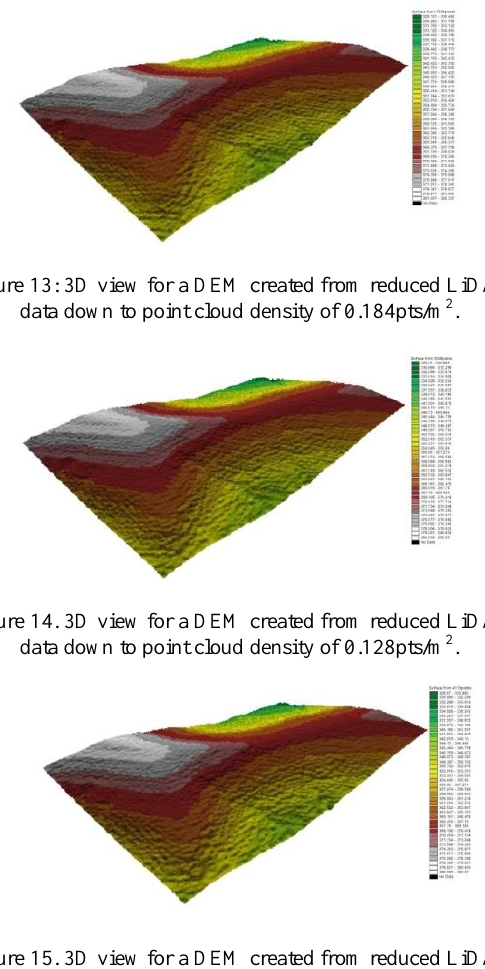
Figure 15. 3D view for a DEM created from reduced LiDAR data down to point cloud density of 0.101pts/m 2 .